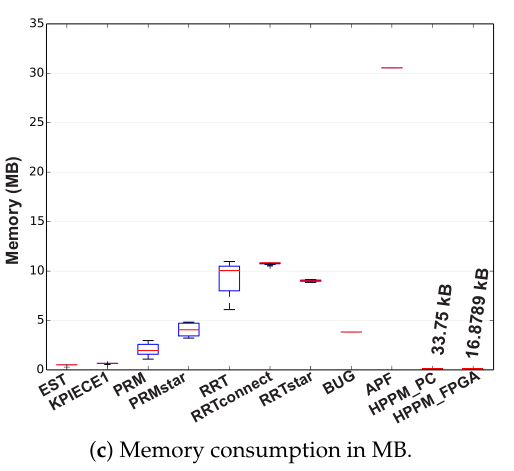
Figure 18. 50 obstacles